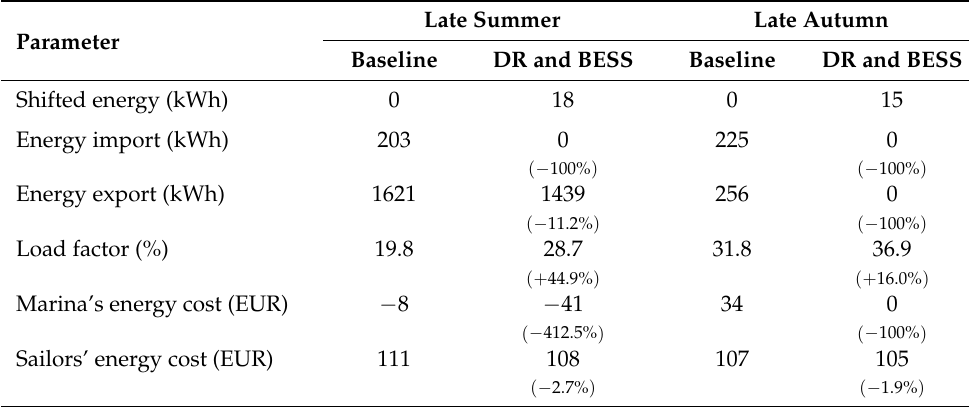
Table 5. Simulation results for late summer and late autumn